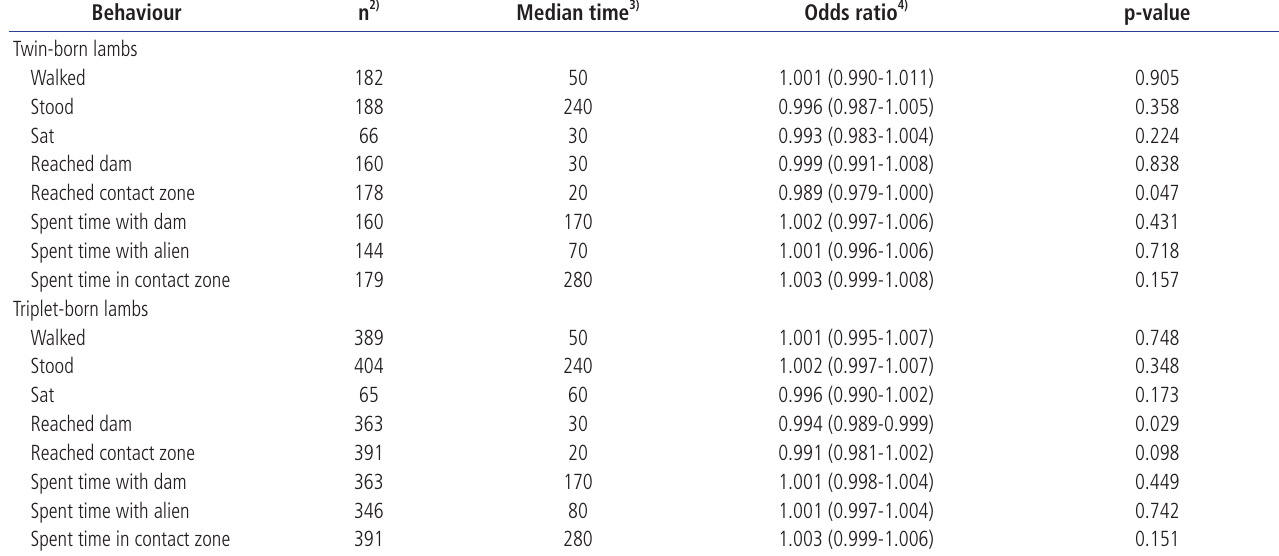
Table 5. Duration of behaviours of twin and triplet lamb during the maternal recognition test 1)